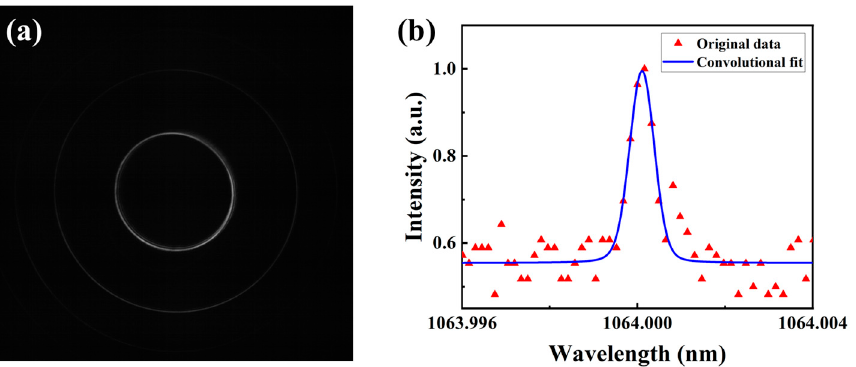
Figure 7. ( a ) Interference circles at low power (R = 95%) and ( b ) interference data and convolutional fit results.